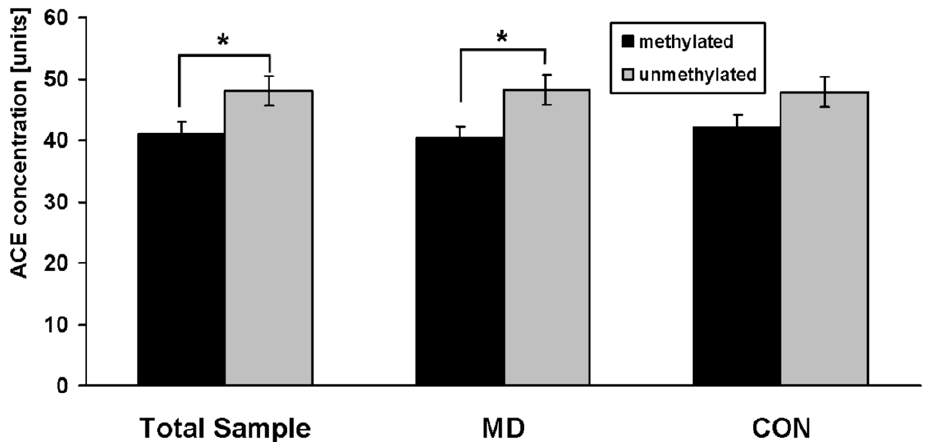
Figure 3. ACE serum concentrations (baseline) among the total sample, medication-free depressive patients (MD) and controls (CON) in relation to their methylation status in the ( 2 456/ 2 255) region of the ACE gene. Methylated probes showed lower ACE concentrations (p=0.005, F=8.1). This effect was also obvious in depressive patient (p=0.03, F=5.1). In the control group there was a similar pattern, but without statistical significance. *: p , 0.05 (ANCOVA). Data are mean values 6 s.e.m.